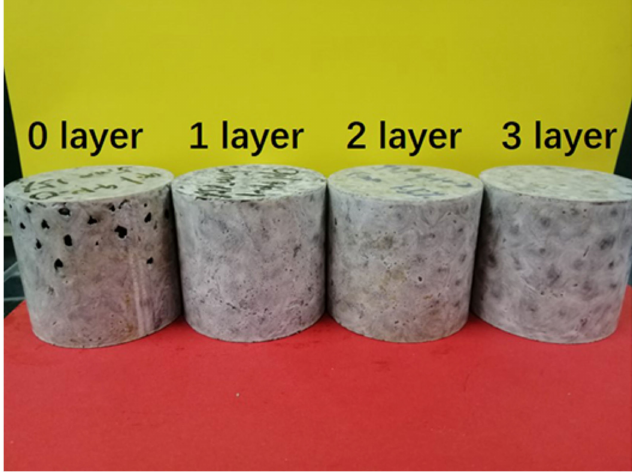
Figure 9. ESF filled with 90% AR-HEMS with different layers.